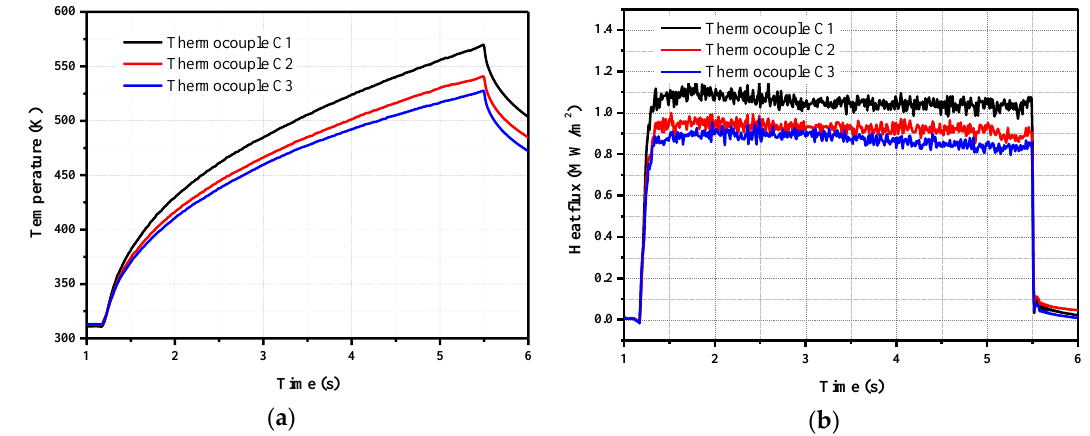
Figure 16. Results of the arc tunnel flow field calibration tests. ( a ) Temperatures of the coaxial thermocouple; ( b ) Heat flux obtained from the coaxial thermocouples.